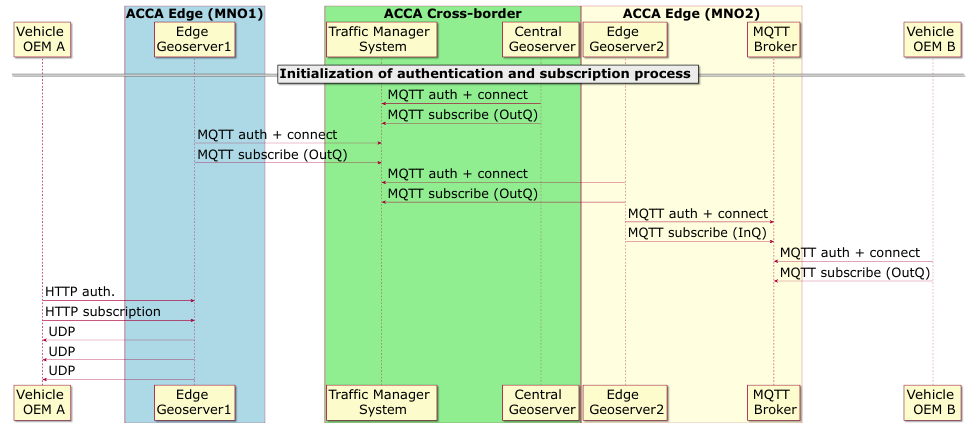
Figure 2. Authentication and subscription process for the connectivity establishment between vehicle on-board unit (OBUs) and the backend services on the edge, and between backend services.